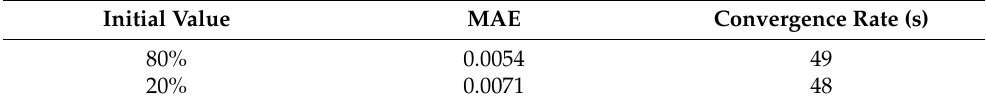
Table 3. MAE and convergence rate at 25 °C.